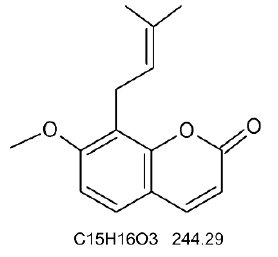
Figure 1. The chemical structure of Osthole.